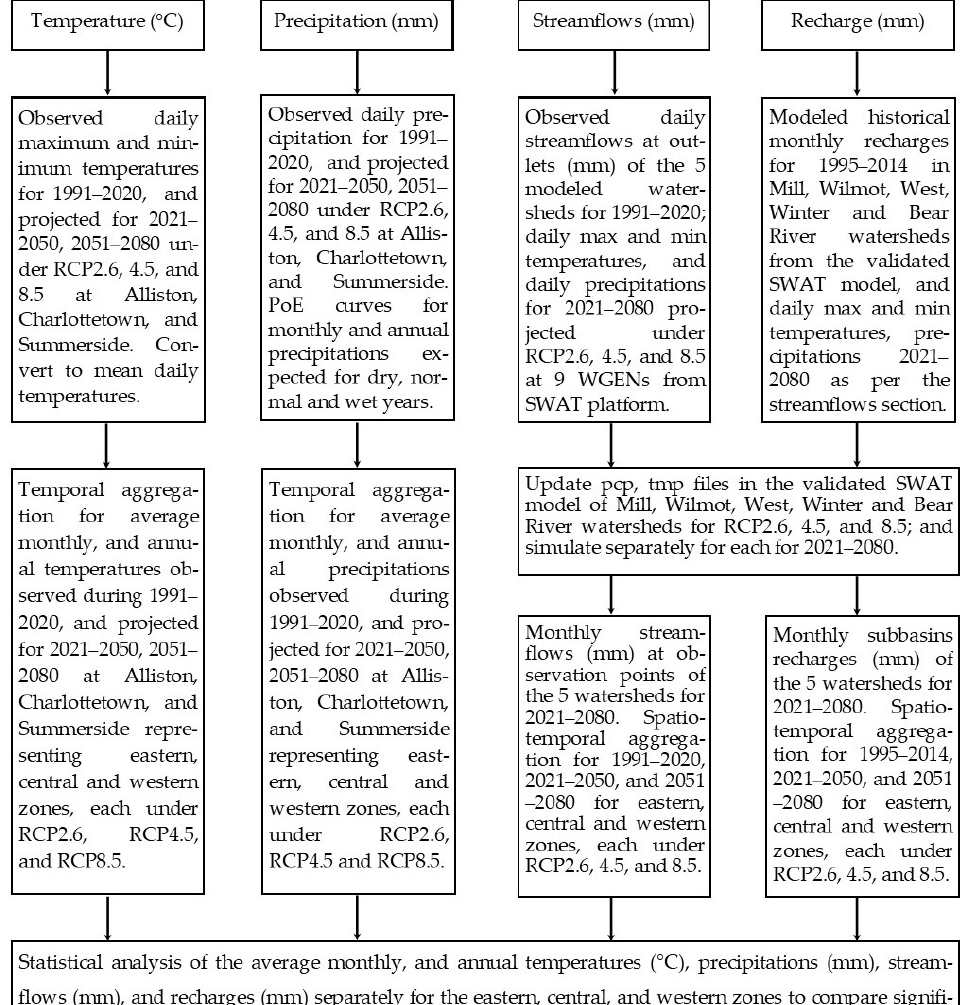
Figure 3. Logical flow diagram of the methodologies adopted under the study (RCP: Representative Concentration Pathways).